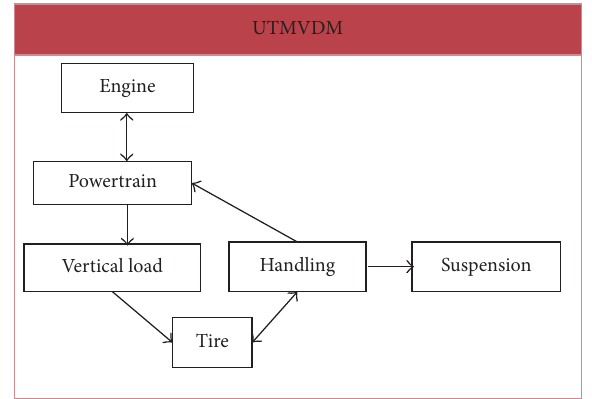
Figure 4: Interactions among the subsystems of UTMVDM.